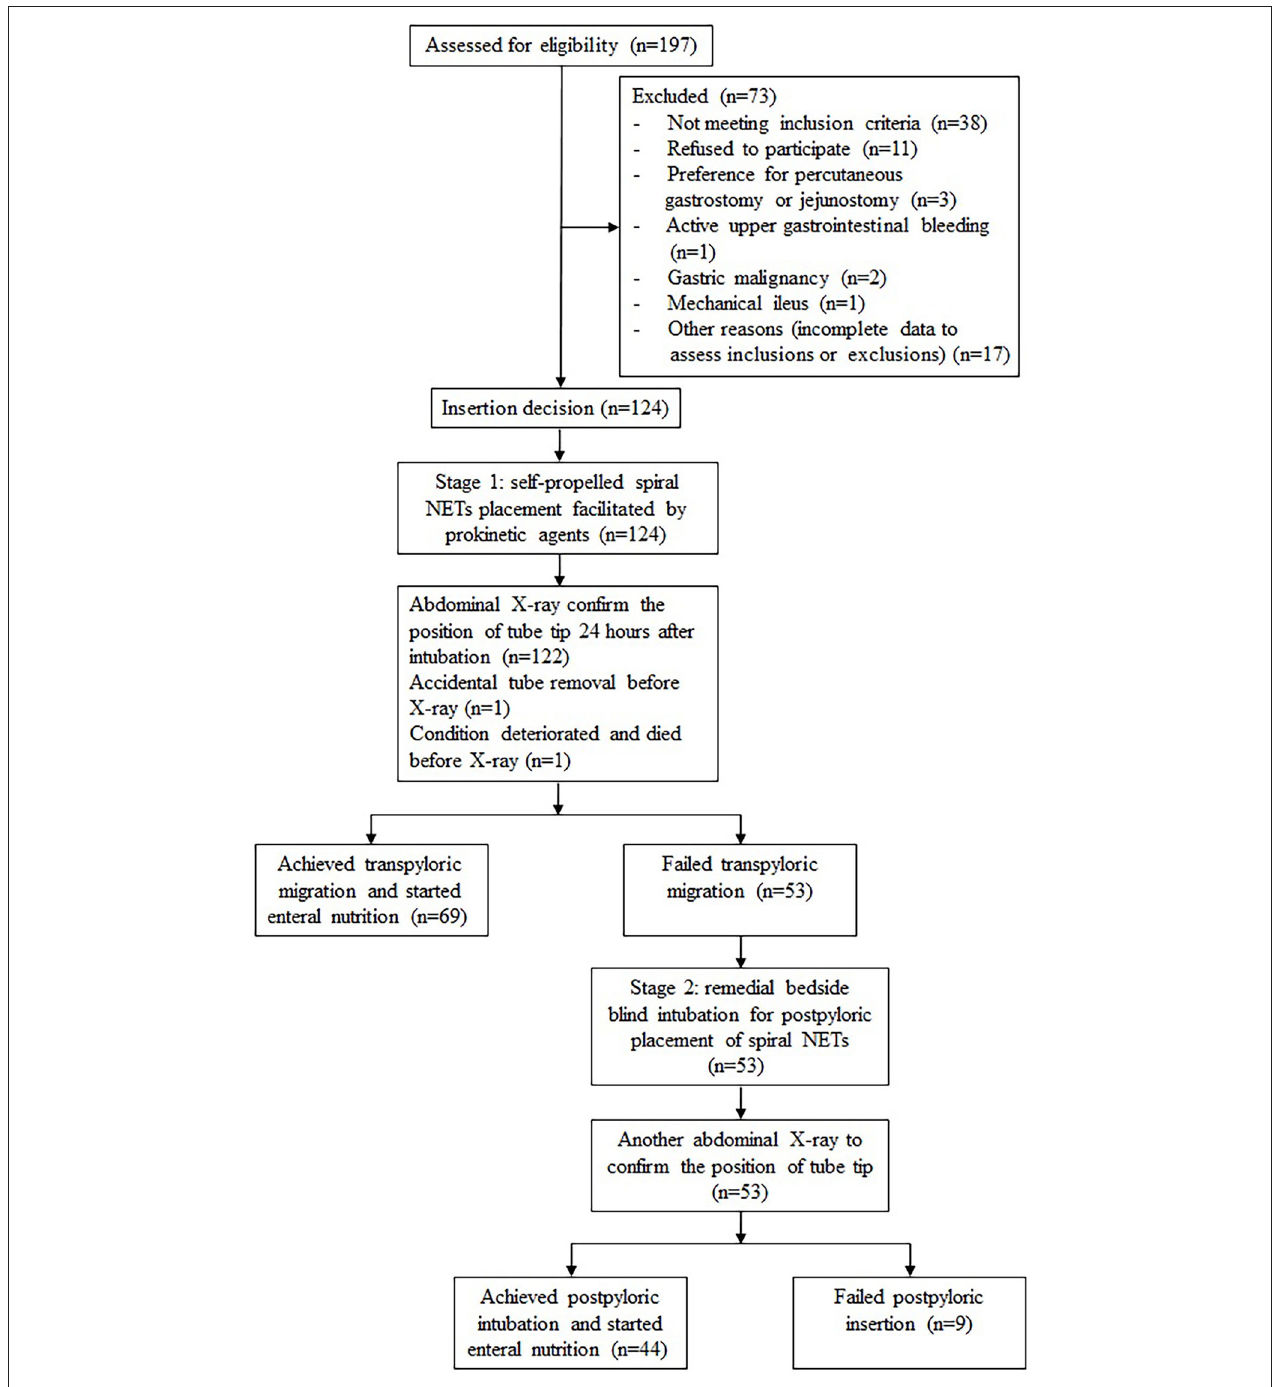
FIGURE 1 | Flowchart of the study population, NETs nasoenteric